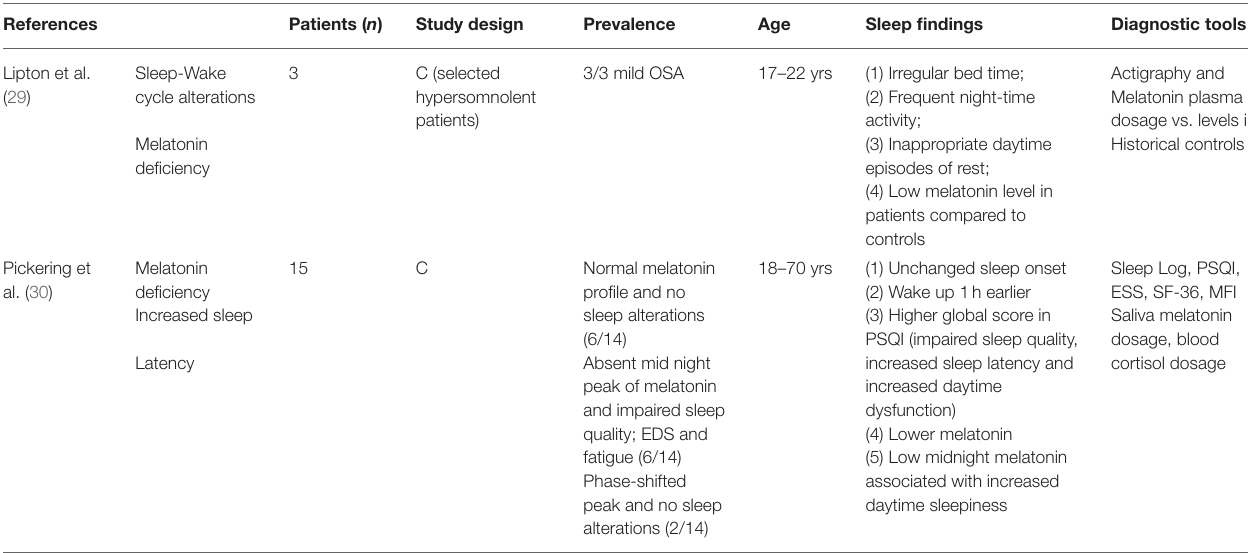
TABLE 3 | Sleep-wake cycle alterations in patients with